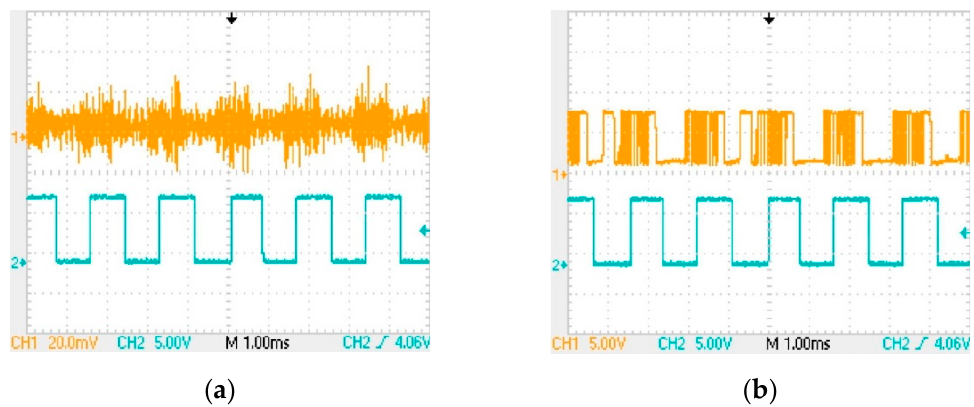
Figure 15. Signal comparison diagram: ( a ) comparison of the OUT5 signal with the signal in the receiving coil; ( b ) the comparison between the OUT5 signal and the output OUT1 signal of the amplifier circuit.